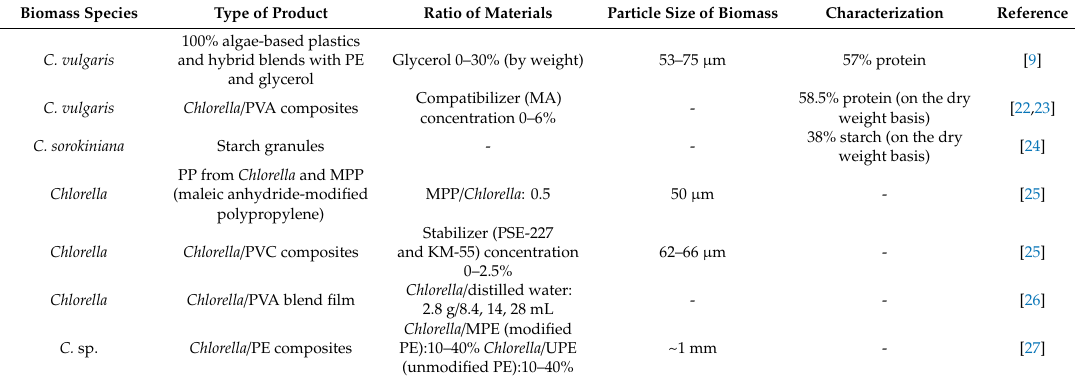
Table 1. Summary of conducted studies: Chlorella , C. vulgaris , C. sorokiniana and C. sp.